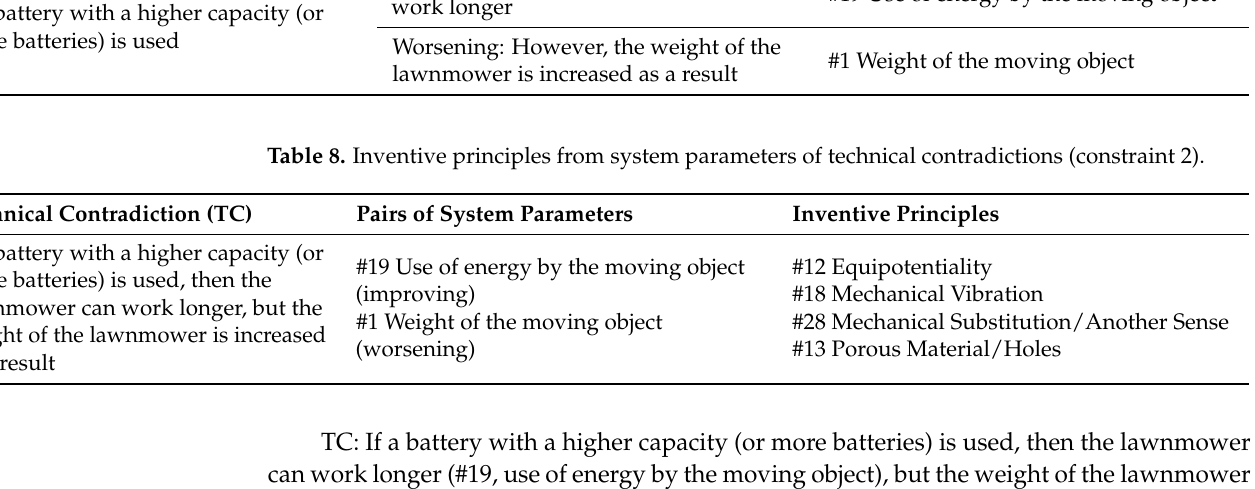
Table 7. System parameters for technical contradictions (constraint 2).